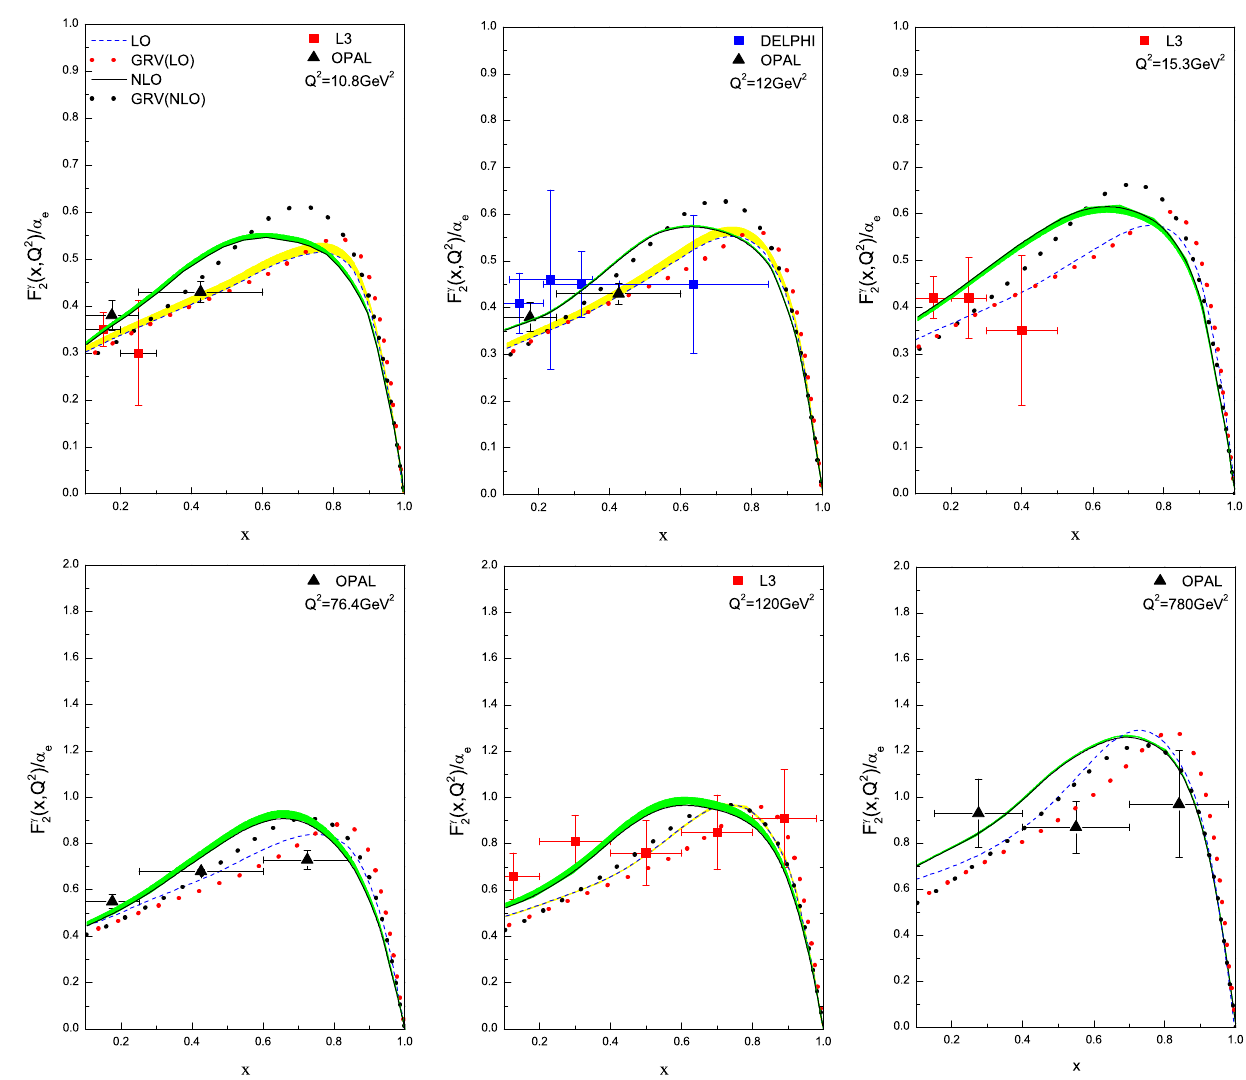
γ at LO and NLO with L3, DLPHI, and OPAL data as well as with the GRV 2